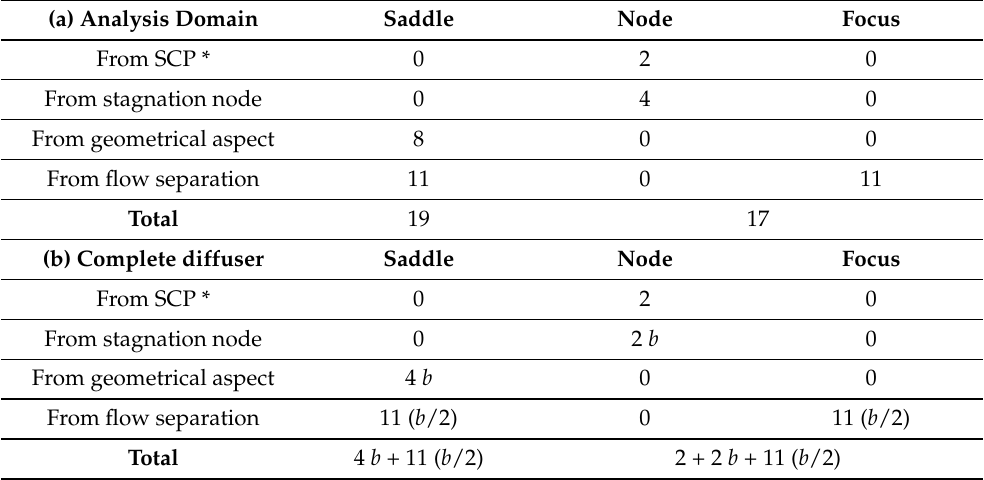
Table 3. Critical points